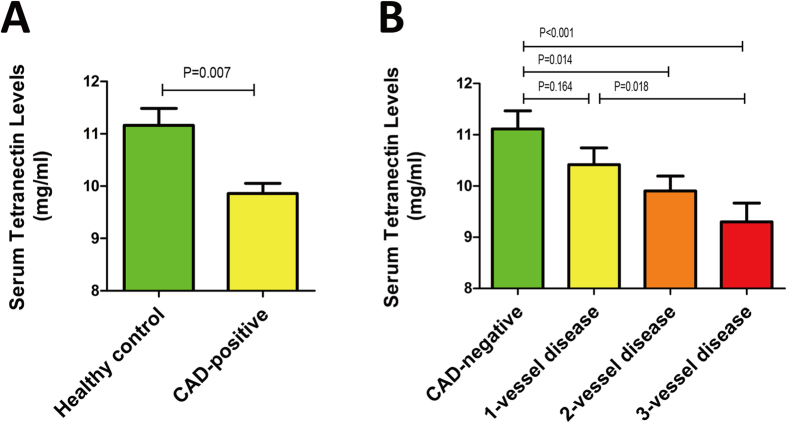
Serum levels of tetranectin (TN) in the study groups.Results are presented as mean±SEM. (A) Serum levels of TN in healthy controls and CAD patients. (B) Levels of TN in patients with and without significant CAD. A stepwise elevation in the TN levels was found depending on the number of significantly diseased coronary arteries (>50% stenosis). P = 0.009 for trend.